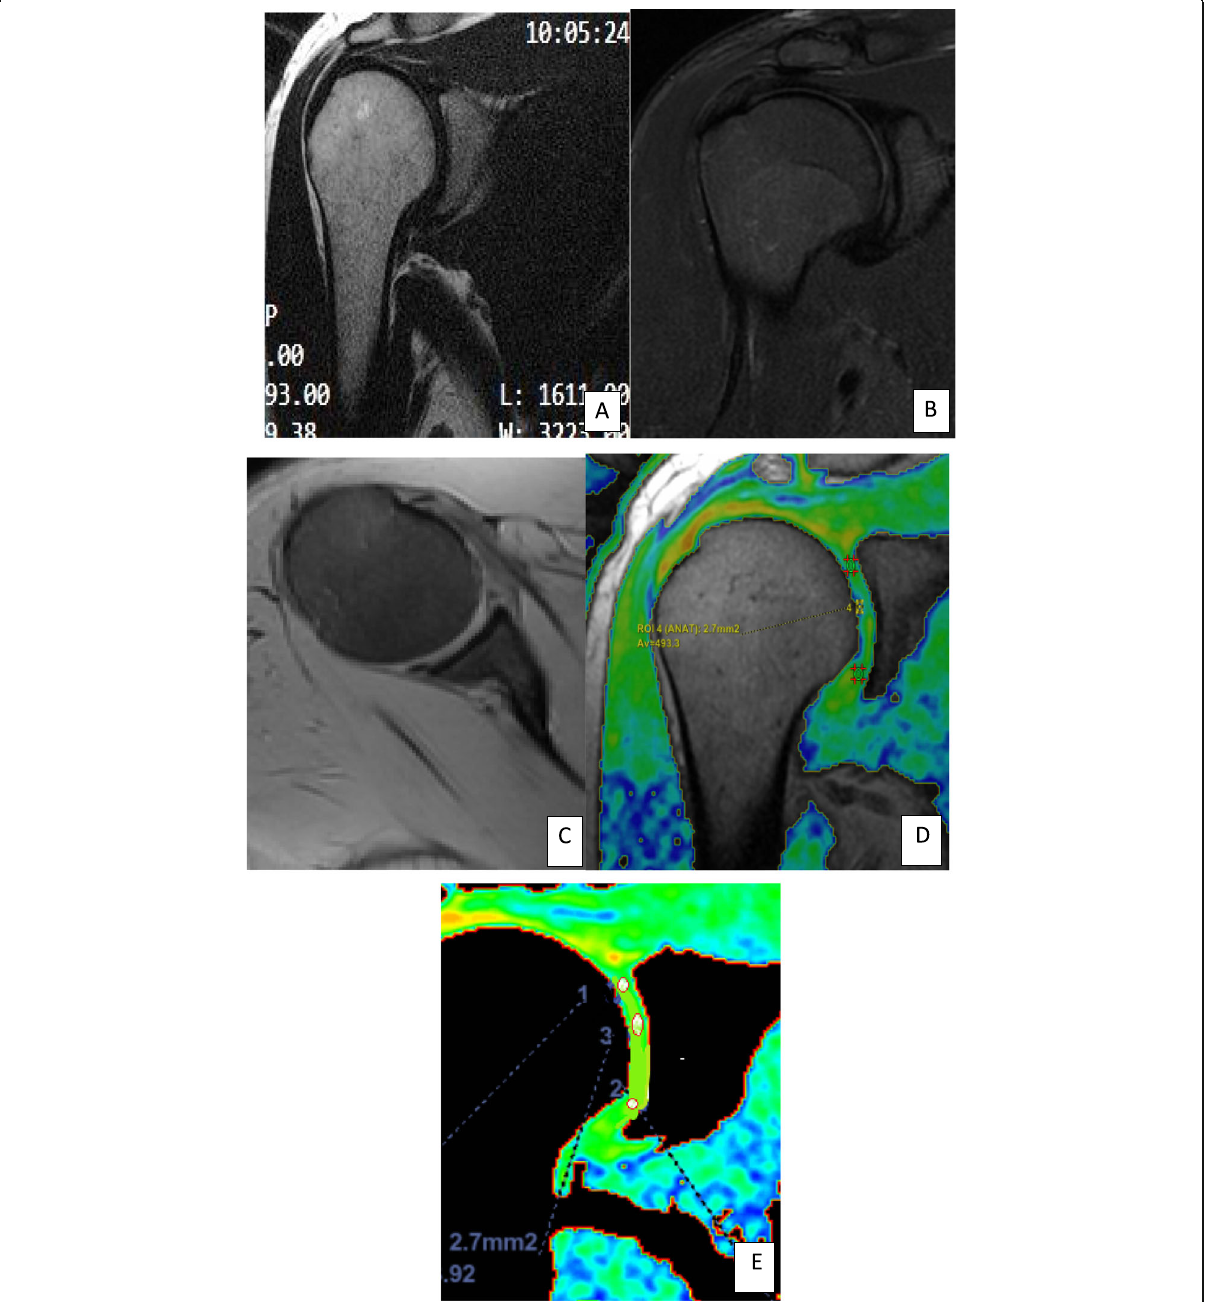
Fig. 1 a Coronal T1 WI. b Coronal proton density (PD) WI. c An axial T2WI in control individual with no detectable osteoarthritic changes. d T2 colored mapping. e Processed image showed average T2 values of 36.4 ms, 40.83 ms and 41.56 ms ,glenoid zone (2), mid zone (3), and humeral zone (1) respectively ( red